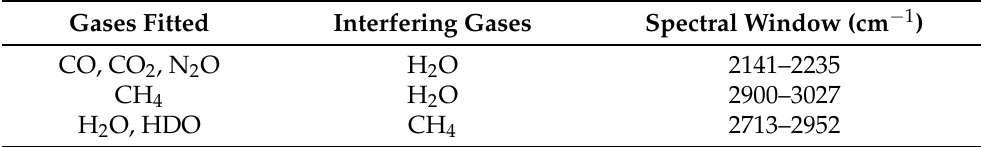
Table 1. Retrieved gases and spectral windows used for the OP-FTIR in this